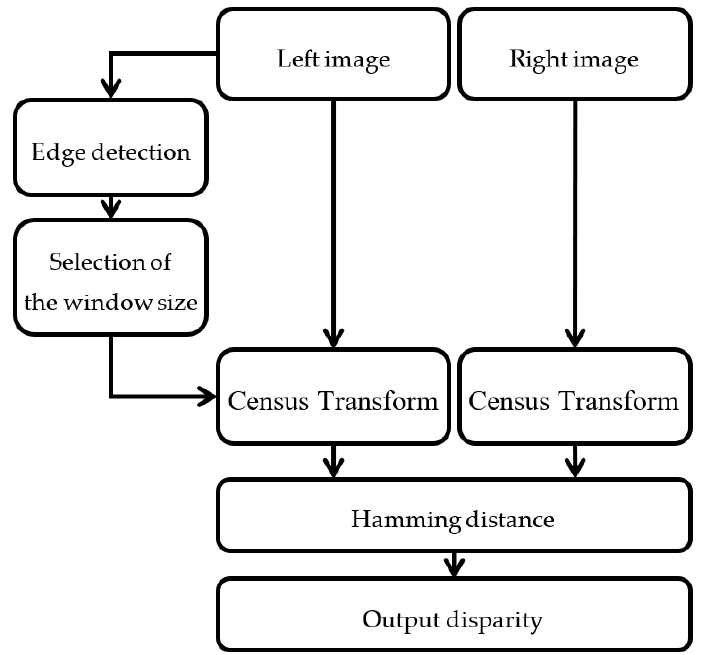
Figure 4. The flowchart of the adaptive window census transform (AWCT).